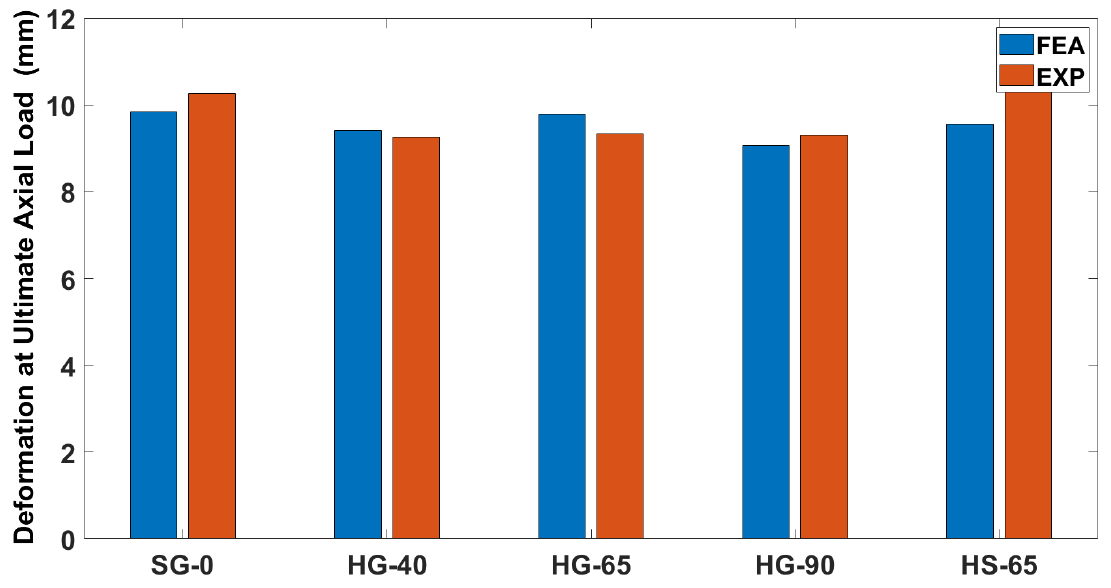
Figure 15. Deformations at ultimate axial load-carrying capacities.